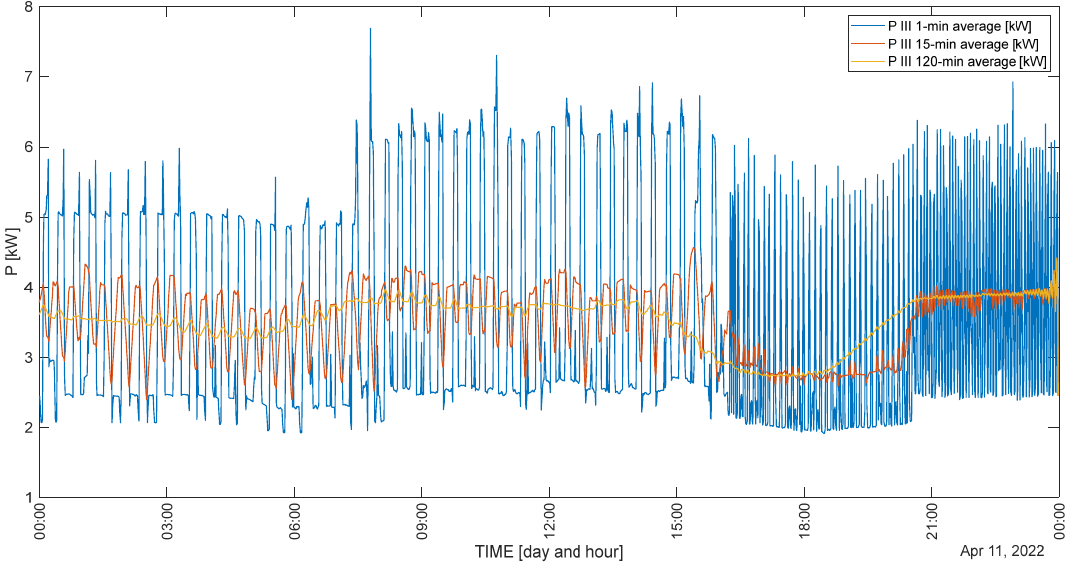
Figure 9. Three-phase active power as a function of time on a representative day of the 1st stage.